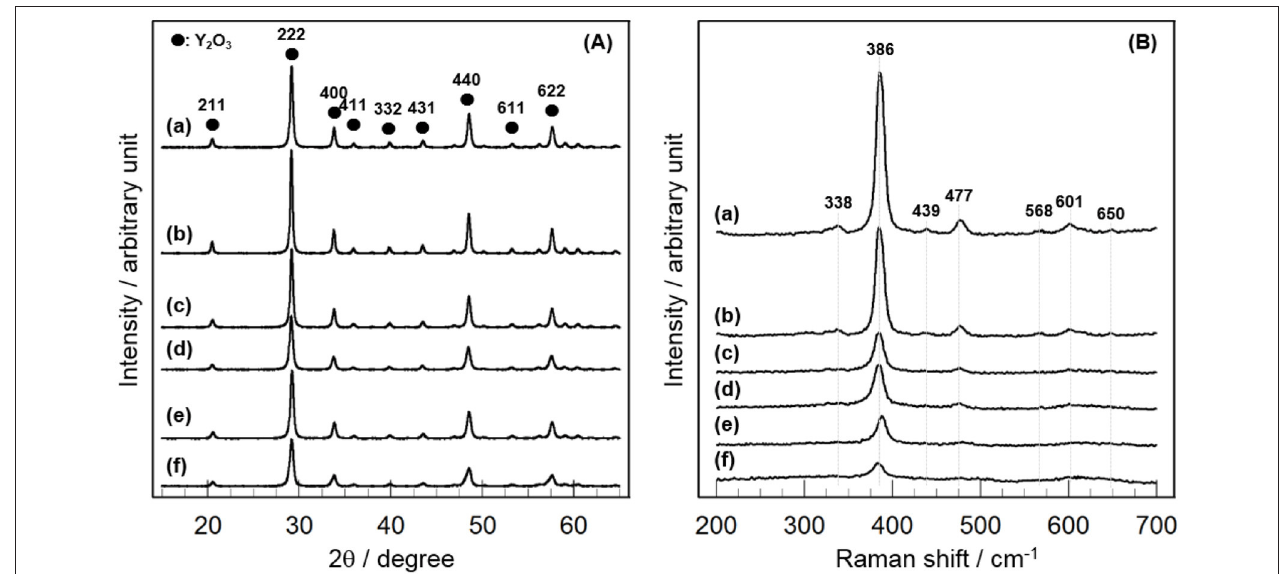
FIGURE 3 | Structural characterization of CeO 2 ( x )/Y 2 O 3 (CP) by (A) XRD and (B) Raman. (a) Y 2 O 3 , (b) CeO 2 ( 1 )/Y 2 O 3 (CP), (c) CeO 2 ( 3 )/Y 2 O 3 (CP), (d) CeO 2 ( 4 )/Y 2 O 3 (CP), (e) CeO 2 ( 5 )/Y 2 O 3 (CP), (f) CeO 2 ( 10 )/Y 2 O 3